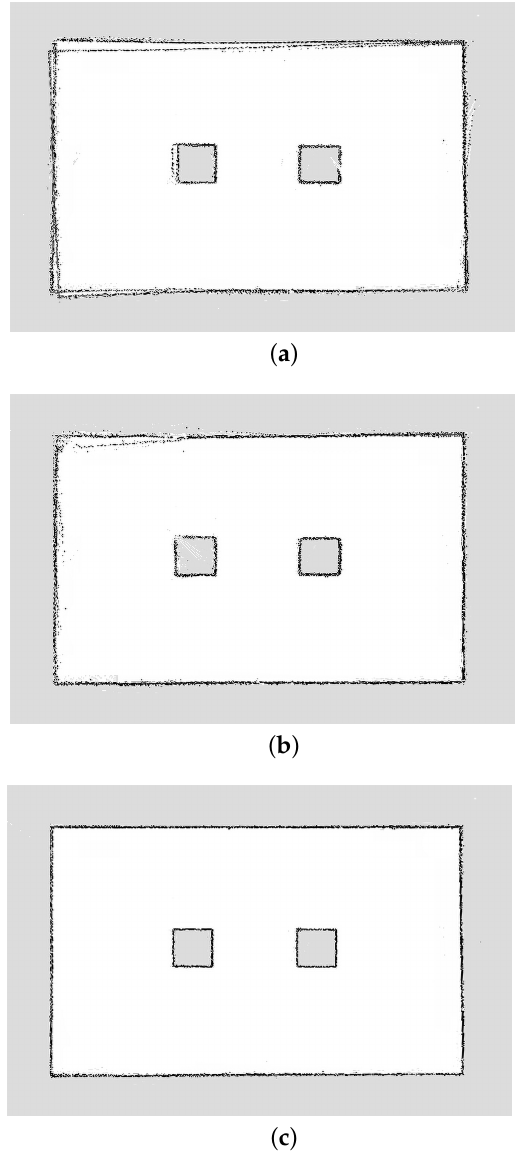
Figure 12. Grid map by different algorithm. ( a ) PSO-FastSLAM. ( b ) AGA-FastSLAM. ( c )